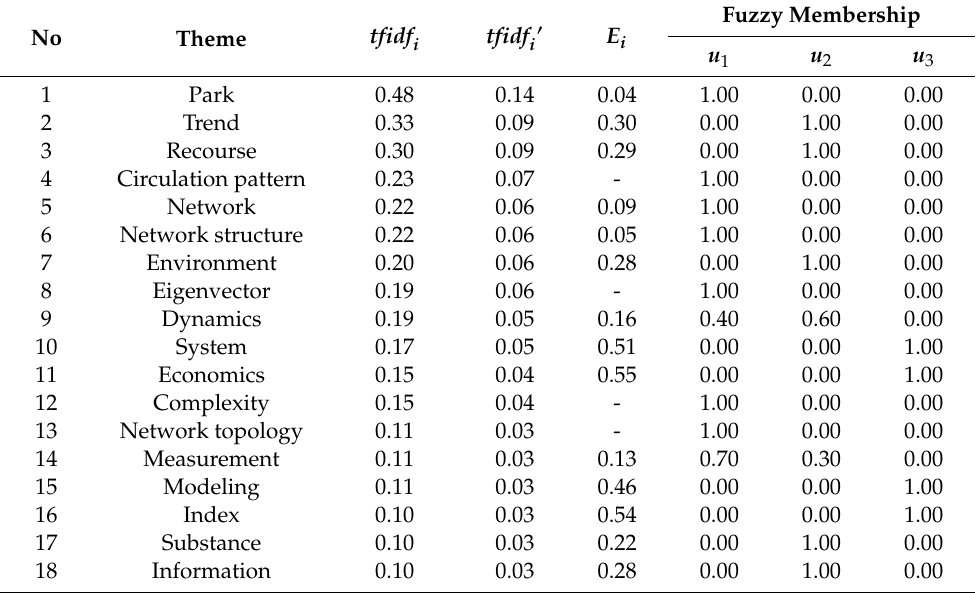
Table 1. The weight of the required knowledge subject and fuzzy membership